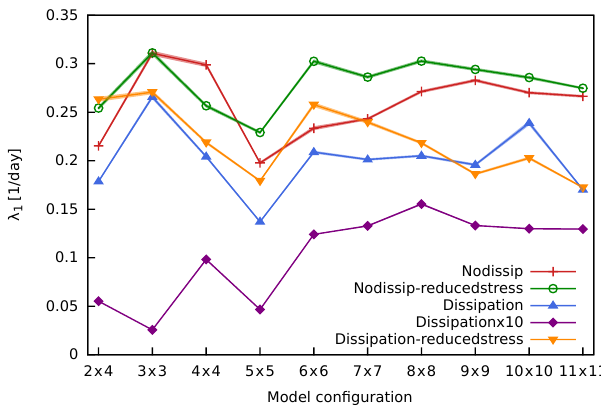
Figure 10. The largest Lyapunov exponent λ 1 of MAOOAM as a function of the model resolution for the different experiments: nodissip (red pluses), nodissip-reducedstress (green circles), dissi- pation (blue upward-pointing triangles) dissipationx10 (purple di- amonds), dissipation-reducedstress (orange downward-pointing tri-